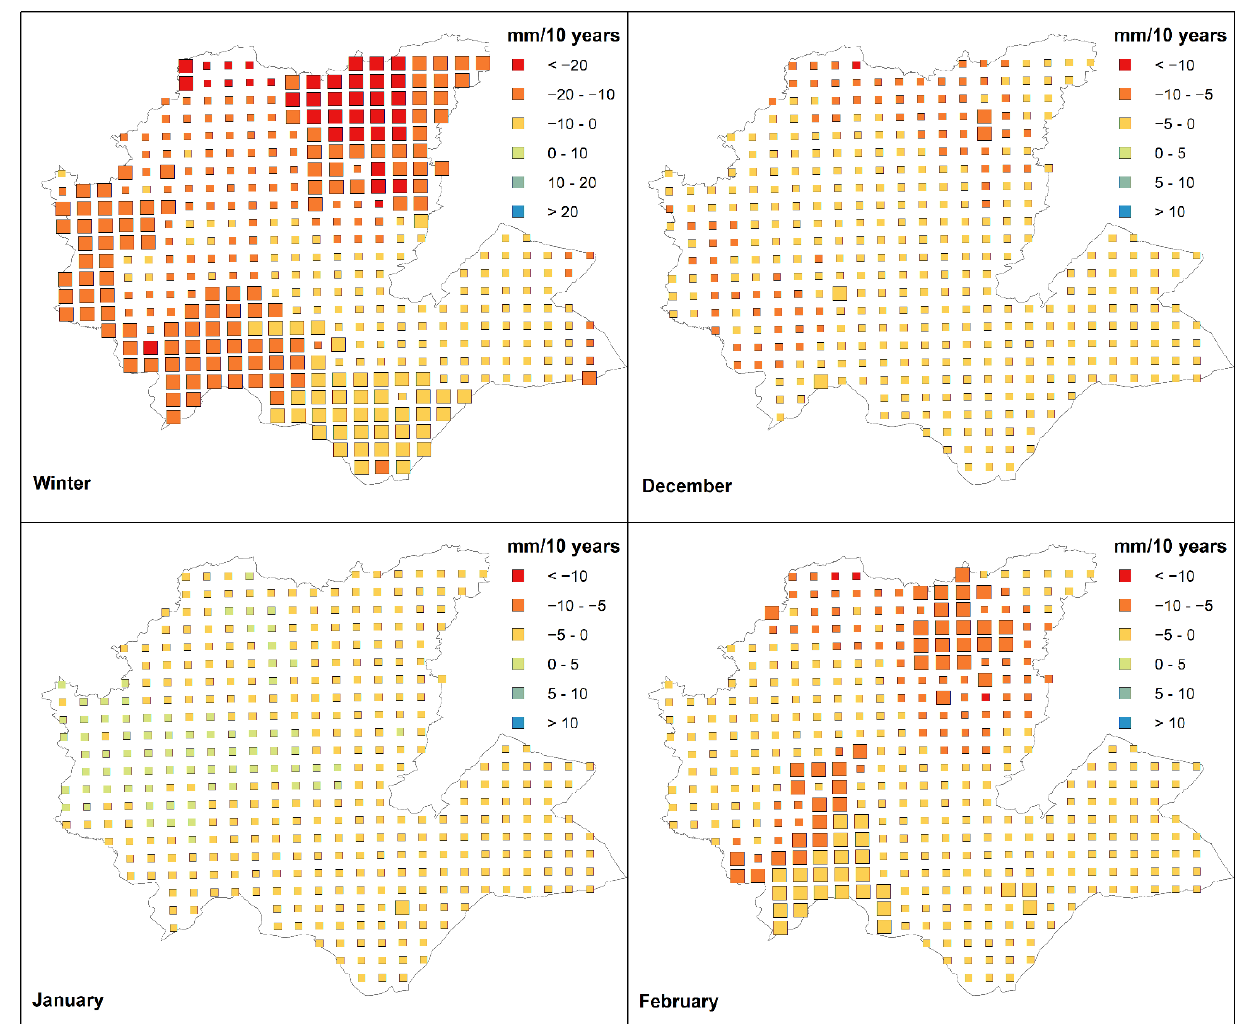
Figure 6. Theil–Sen Slope for winter season and its constituent months in mm per decade. Squares’ dimensions indicate the significance level of the trend: large squares: p < 0.05, small squares other- wise.